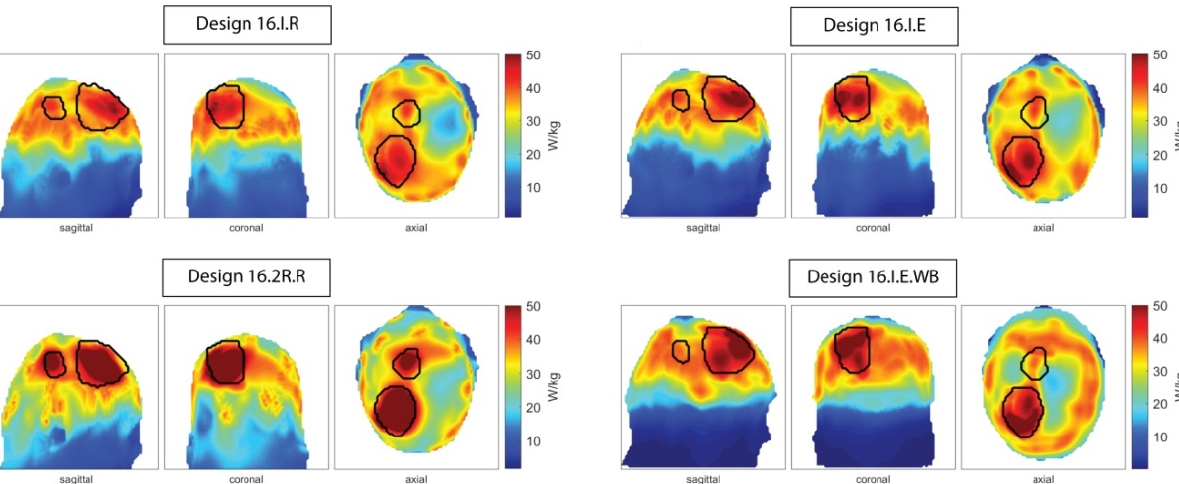
Figure 7. Maximum intensity projections of the SAR 10g distribution in Patient Model 5 obtained using the MVFS optimization with designs 16.I.R, 16.I.E, 16.2R.R, and 16.I.E.WB. These RF exposure patterns were achieved by the cumulative exposure of 3/3/3/2 excitation settings to be played out in a time-interleaved manner. Design 16.2R.R supports successful treatment planning of both sub-TVs with a single optimization run, enabling HT of both sub-TVs in a single session rather than two separate sessions requiring full cooling of the brain for accurate treatment prediction.